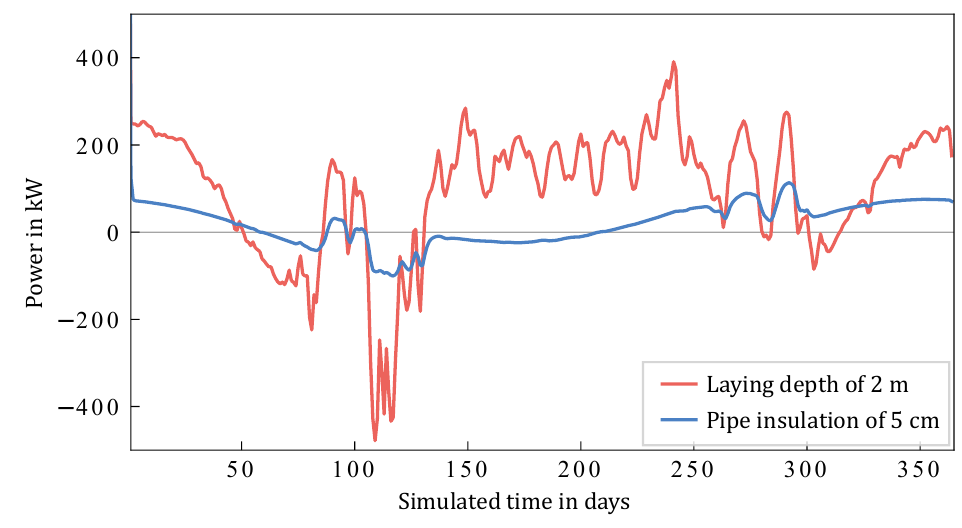
Figure 20. Comparison of heat losses of network with 5 cm insulation and laying depth of 2